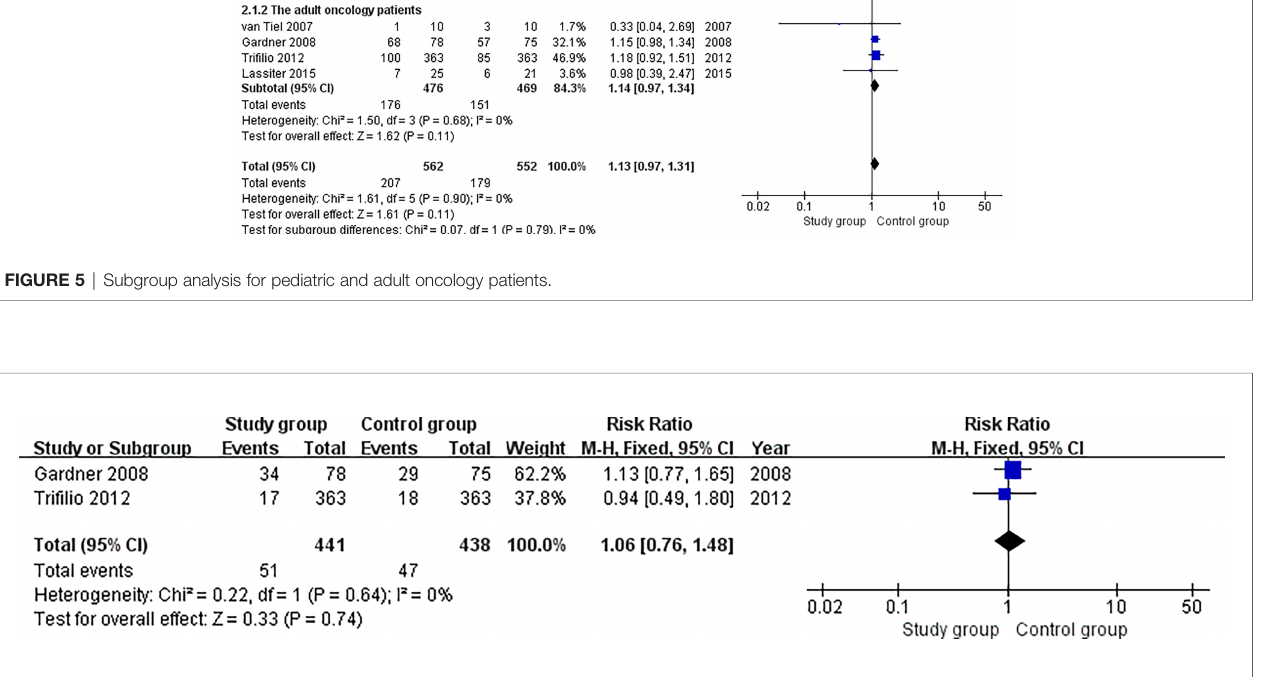
FIGURE 6 | Meta-analysis of the incidence of mortality.